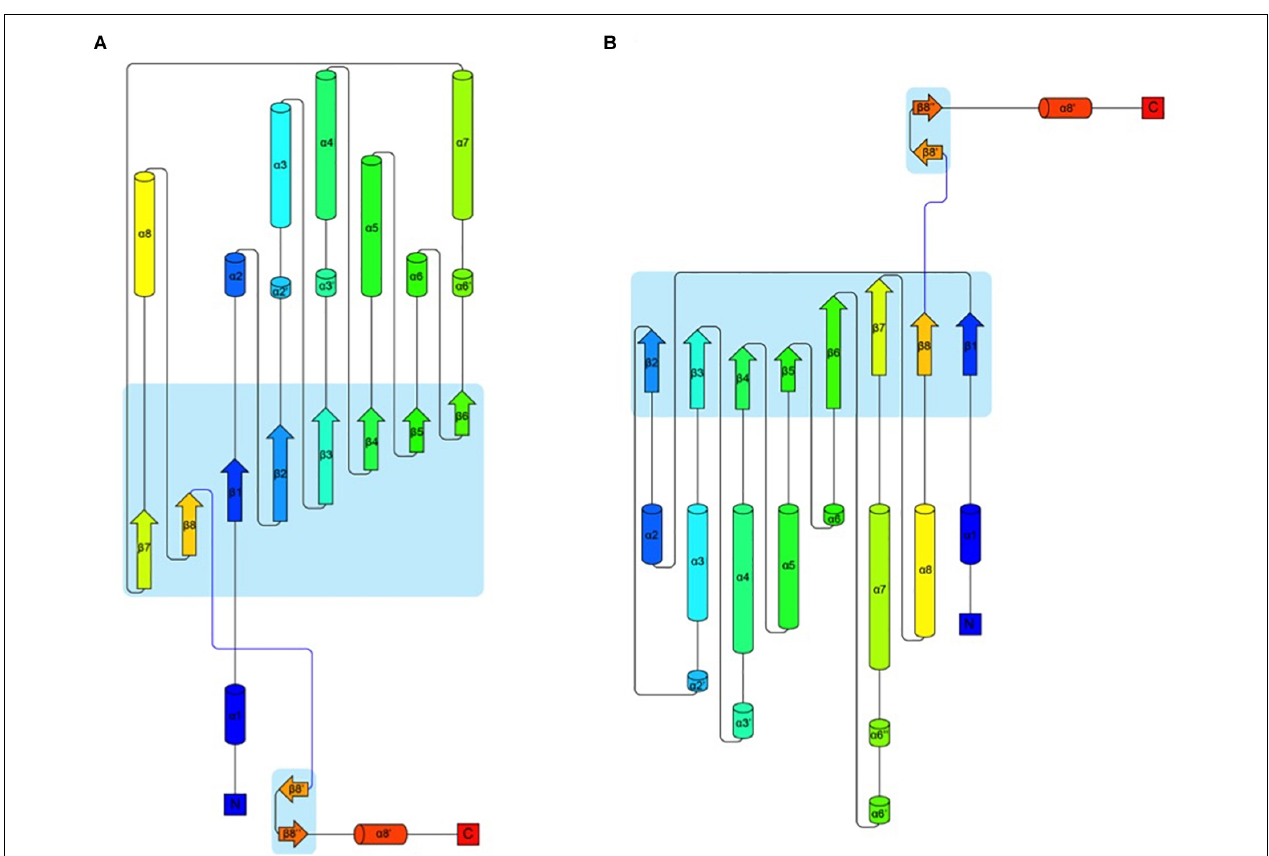
FIGURE 4 | Topology of proteins CelRH5 (A) and 3MMU (B) showing the architecture of their monomers. The colouring is from blue at the N-terminus to red at the C-terminus. Parts of the chain that have a β -strand conformation are shown as arrows and α -helices are shown as cylinders (Stivala et al., 2011).